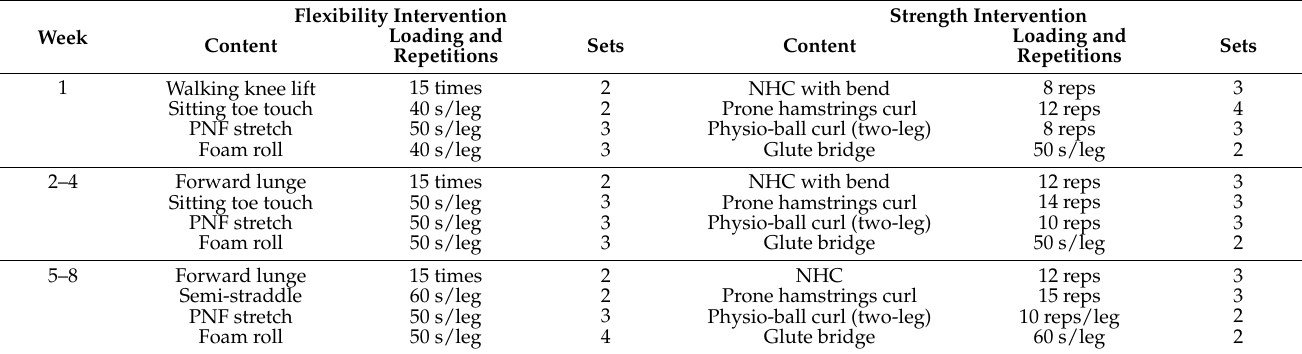
Table 2. Detailed flexibility and strength training